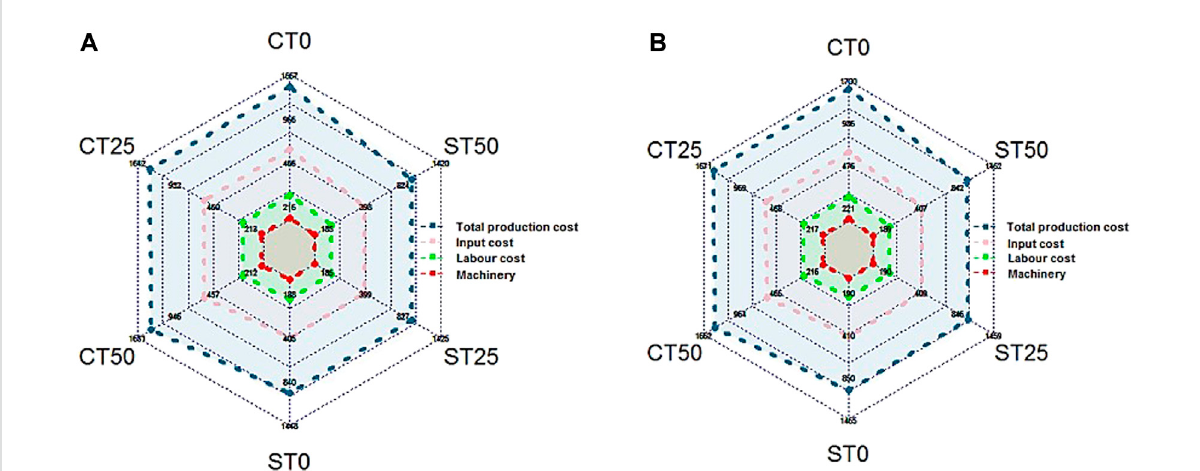
FIGURE 10 Cost of production under TCE techniques with residue management options for rice and maize system in northwest Bangladesh (CT0 = conventional tillage with no residue; CT25 = conventional tillage with 25% residue; CT50 = conventional tillage with 50% residue; ST0 = Strip tillage with no residue; ST25 = Strip tillage with 25% residue; ST50 = Strip tillage with 50% residue during 2019 – 2020 (A) and 2020 – 2021 (B) . Numbers in each spider diagram mention amount in US$.